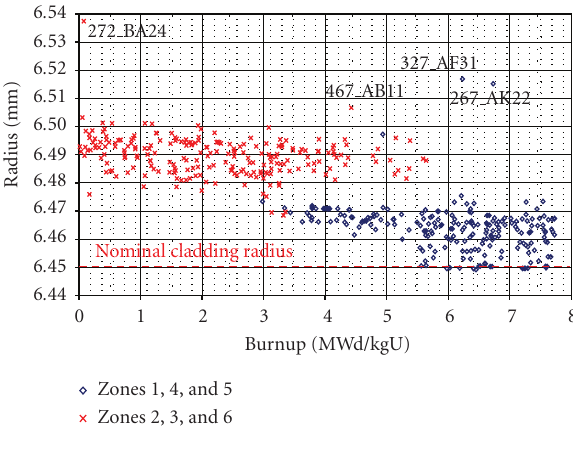
Table 4: Main outcomes from the analysis: zones 2, 3, and